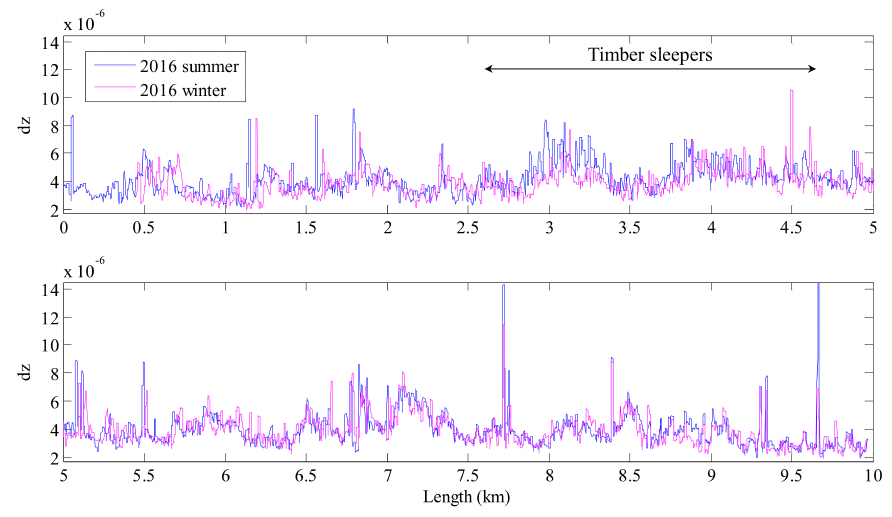
Figure 18. GPR parameter dz , in the time domain, measured in January (winter) and in July (summer) of 2016.